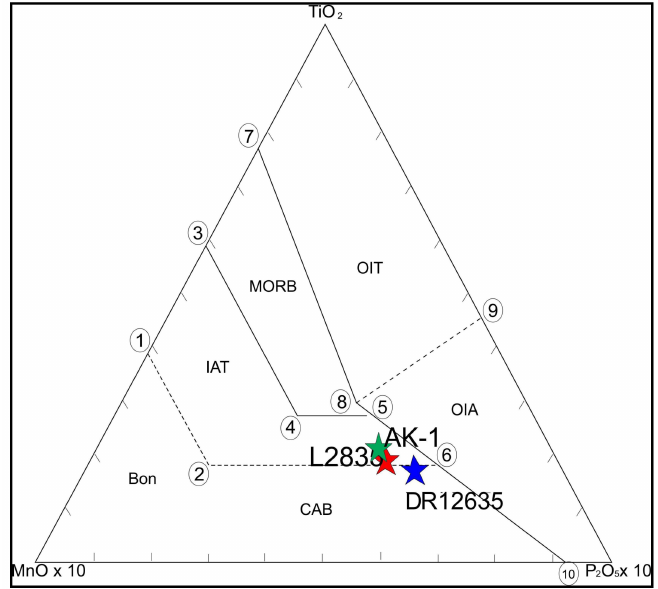
Figure 5. TiO 2 -MnO × 10-P 2 O 5 × 10 diagram modified after